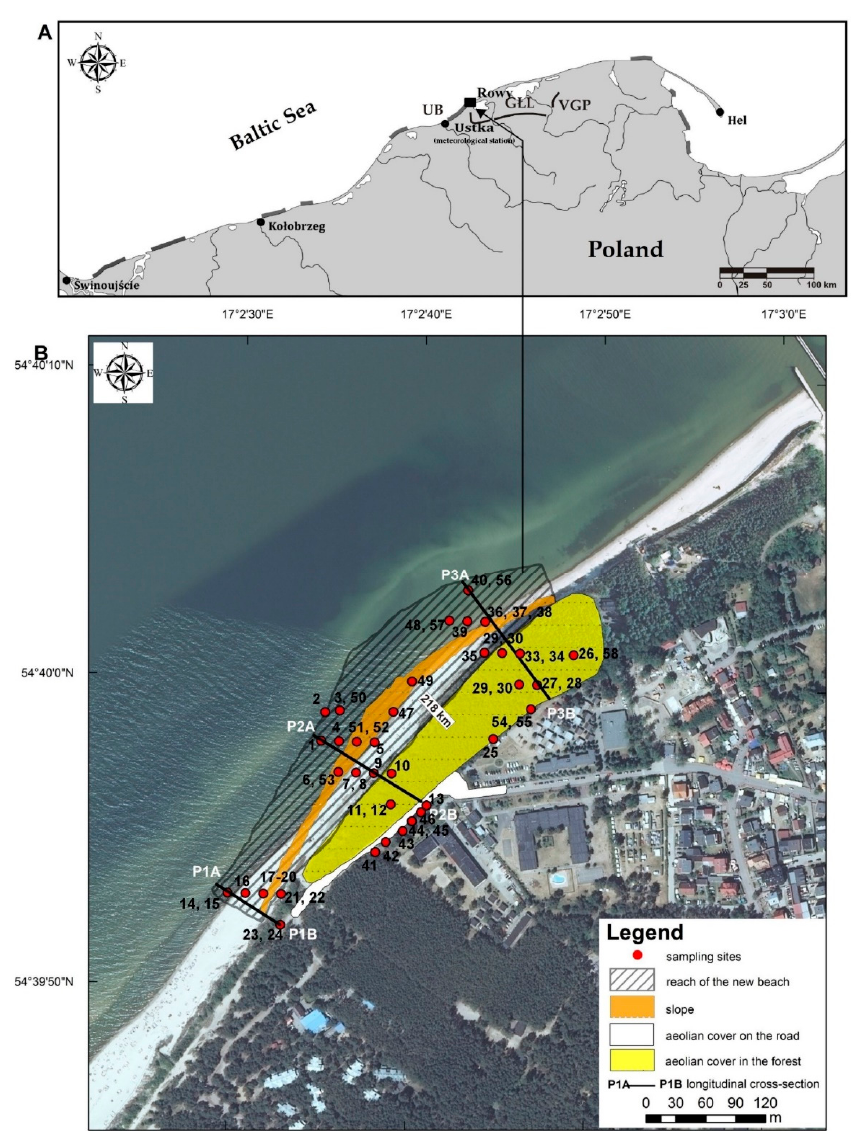
Figure 4. Location of the research area ( B ) against the Polish coast of the Baltic Sea from the village of Piaski in the E (not shown on the map) to ´Swinouj´scie in the W ( A ). Places where beach profiles and sampling were made. The orthophotomap comes from 2011. Sand samples were collected on 27–28 May 2017. Dark grey line, erosive sections; UB, Ustka Bay; G Ł L, Gardnie ń sko- Ł ebska Lowland; VGP, Vistulian Gardno Phase.